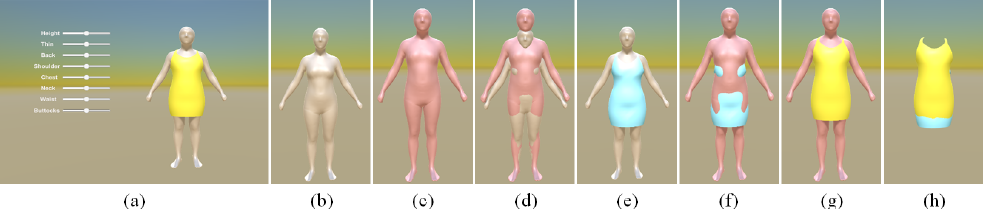
Figure 3. Consistent subject appearance exploration: ( a ) interface for semantic human shape explo- ration: ( b ) source human model; ( c ) target human model; ( d ) overlap of source and target human model; ( e ) source human model with source cloth; ( f ) target human model with source cloth; ( g ) target human model with adapted cloth; ( h ) overlap of source and adapted